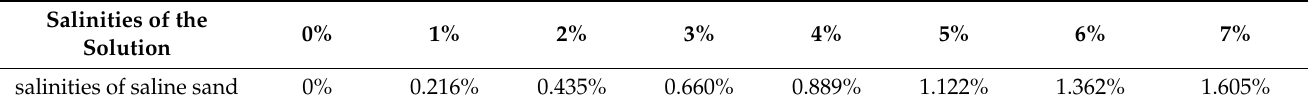
Table 2. Relationship between salinities of solution and salinities of saline